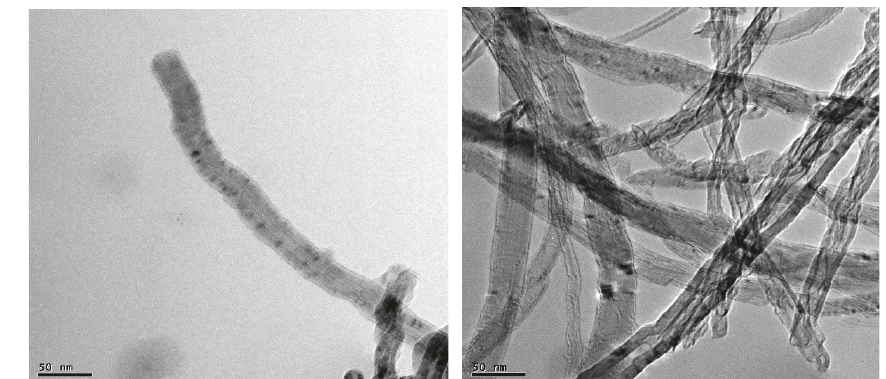
Figure 3: TEM images of MWCNT at 50 nm.